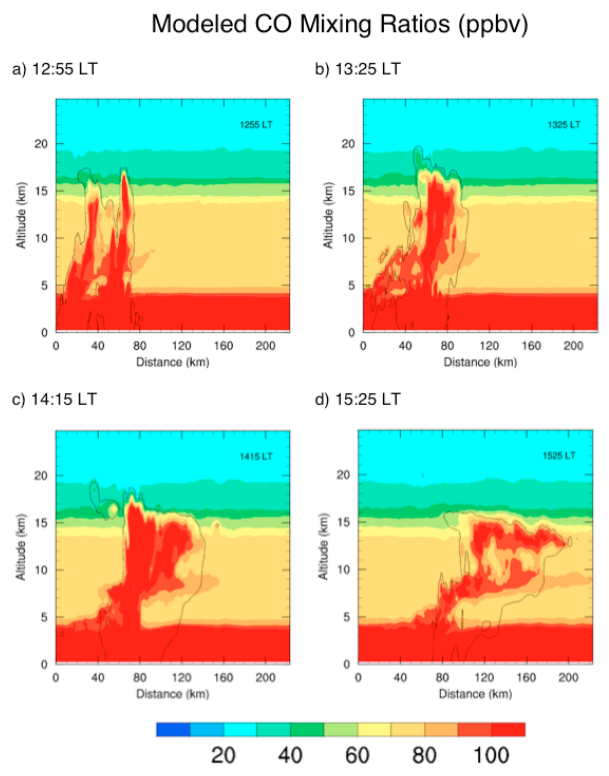
Fig. 10. Time series of vertical cross sections of CO mixing ratios from times (a) 12:55LT, (b) 13:25LT, (c) 14:15LT, (d) 15:25LT, oriented 130 ◦ from north through the storm core. The thin black line indicates the 0.01gkg − 1 total condensate